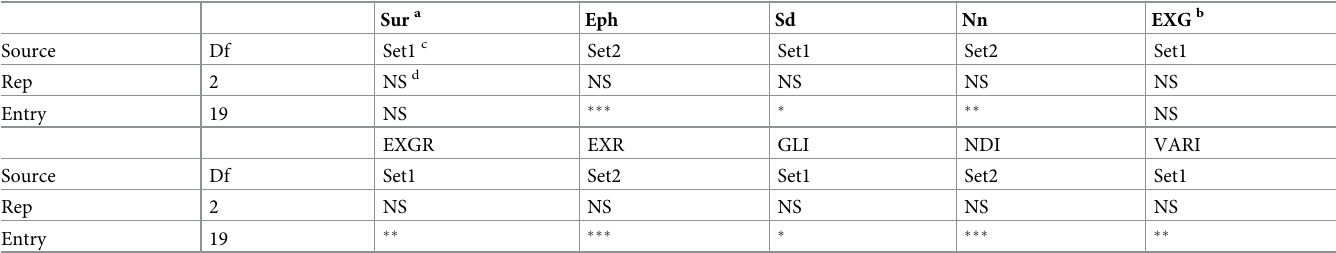
Table 5. Kruskal-Wallis rank sum test at two growth stages.